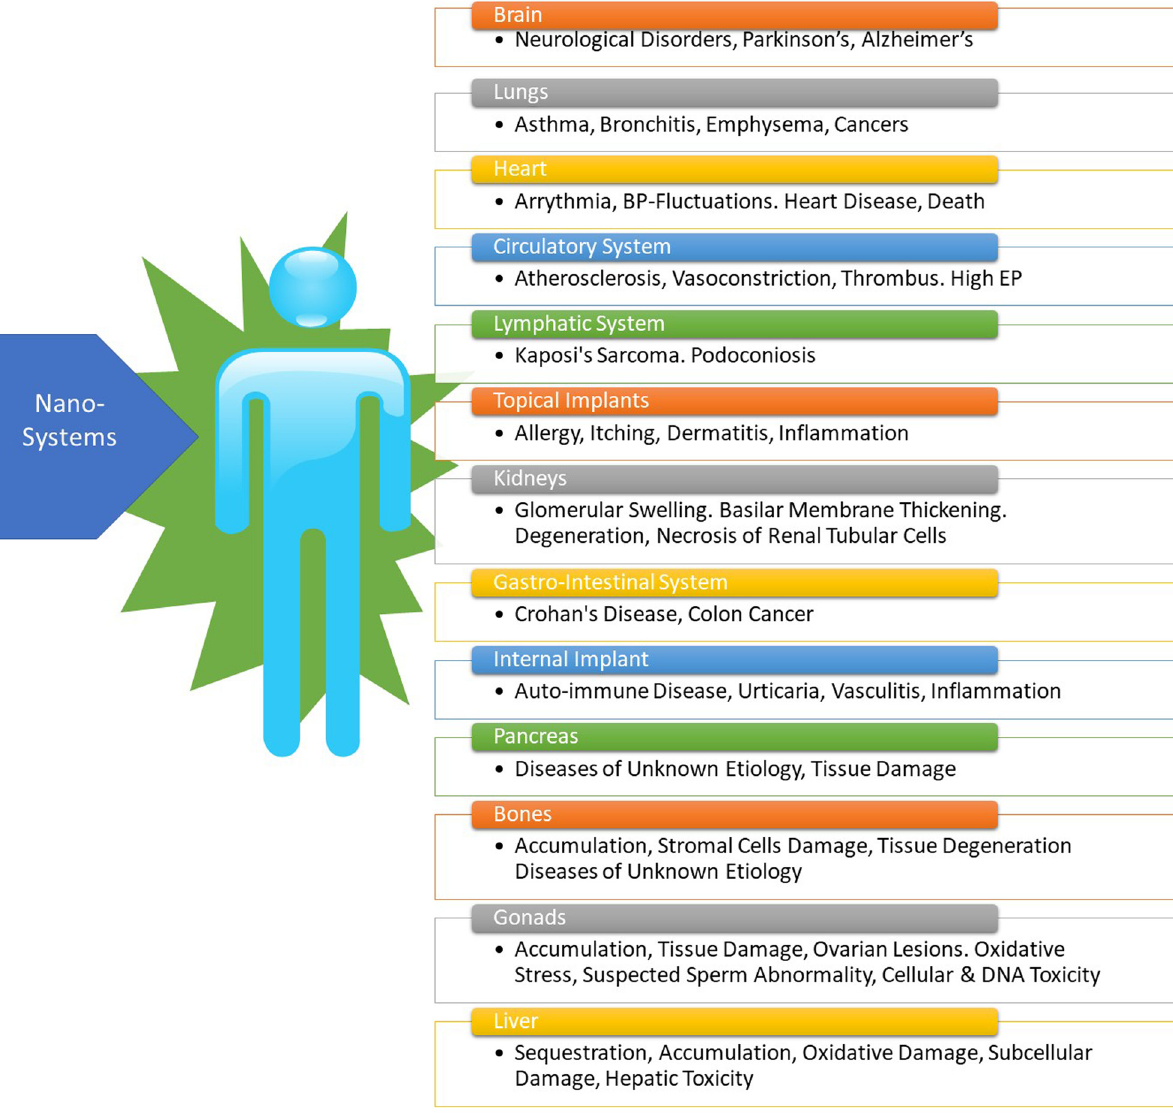
Figure 16: Suspected and con fi rmed diseases from nanomaterial